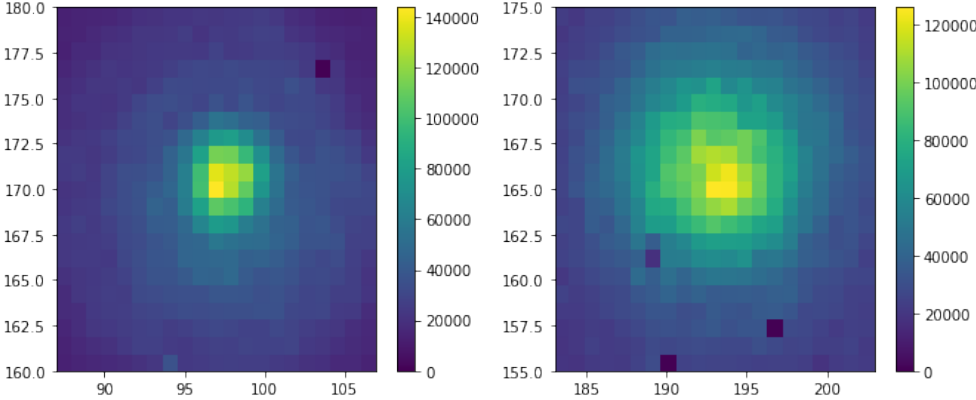
Figure 5. Two-dimensional distribution of pixel occupancy for the two